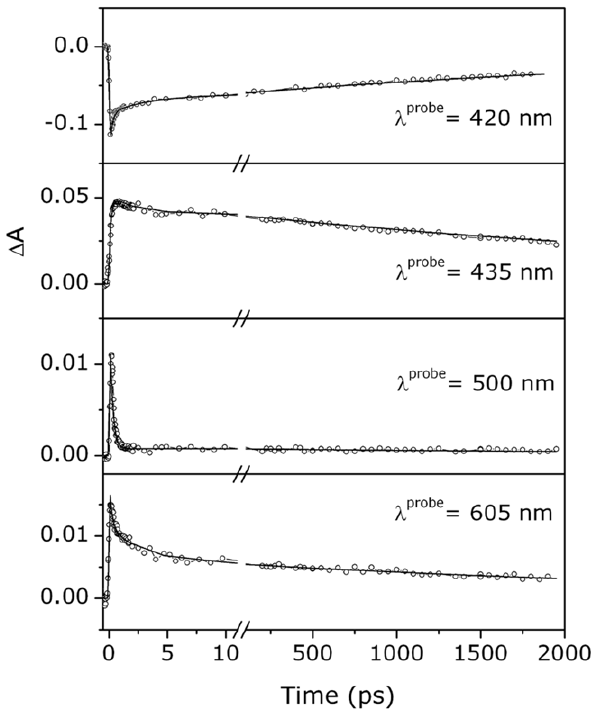
Figure 2. Kinetic profiles at single wavelength. Transient absorbance of the CO complex of the Tf -trHb as a function of the delay time after excitation at 400 nm with femtosecond pulses. Solid lines are the results of the fitting to a multiexponential decay, as reported in Table 1.